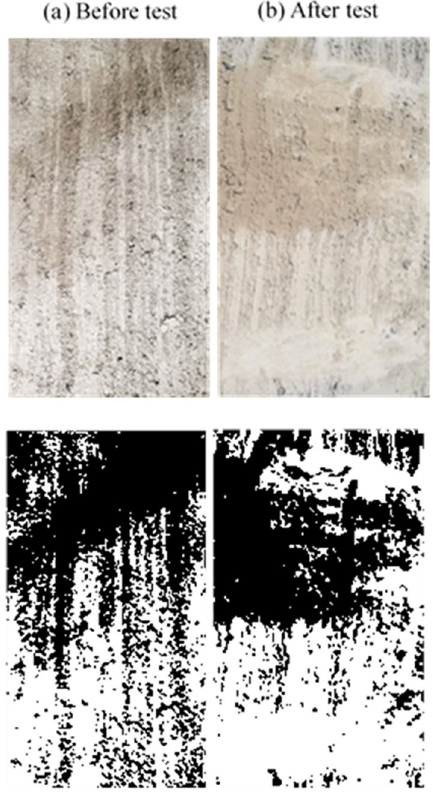
Figure 6. Medium rough surface before and after